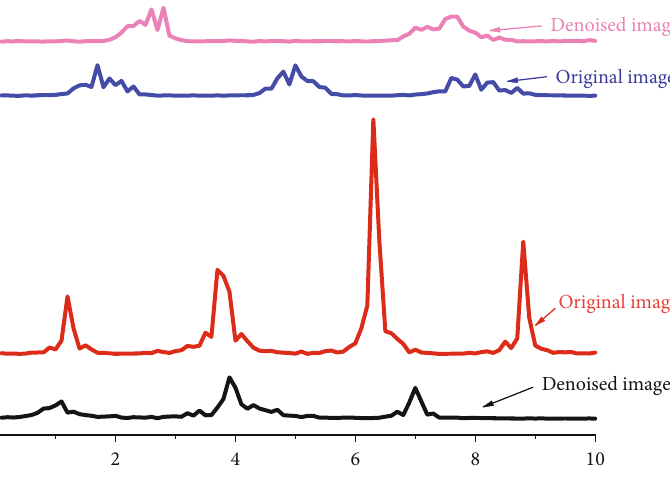
Figure 7: Comparison of grayscale values of ultrasonic images.